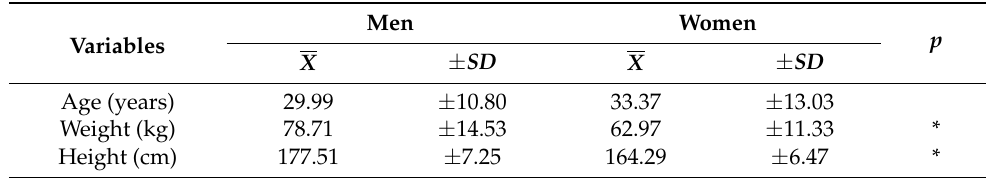
Table 1. General characteristics of the participants.